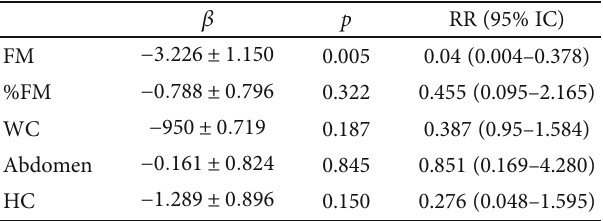
Table 5: Logistic regression model verifying the in fl uence of sex, age, and nutritional factors between Intron 7 G/C polymorphism (rs 4253778) and body